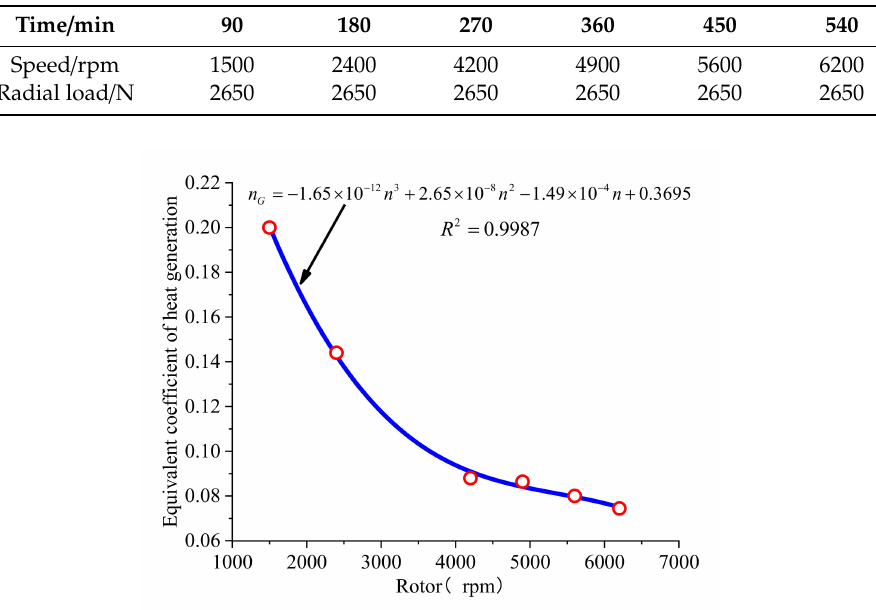
Figure 6. Equivalent coe ffi cient of heat generation under di ff erent working